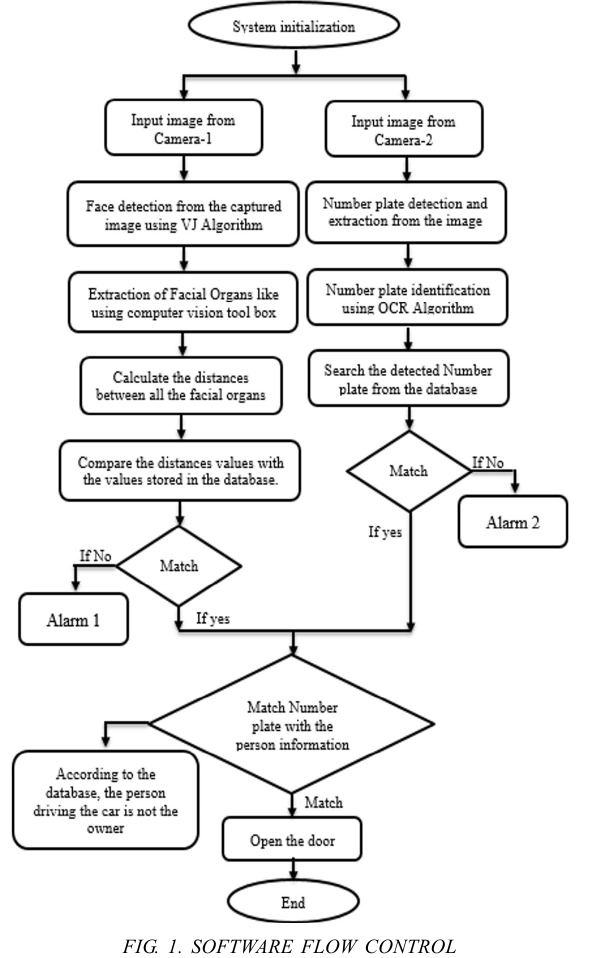
Fig. 2 represent the hardware block model of the proposed system incorporated with both cameras. ARDUINO Uno is utilized for controlling the barrier interfaced with the servo mechanism. IR (Infra-Red) Sensors are placed in the proximity where car needs to stop for image capture, they serve as a guide line for the driver to park the car within the given IR guided